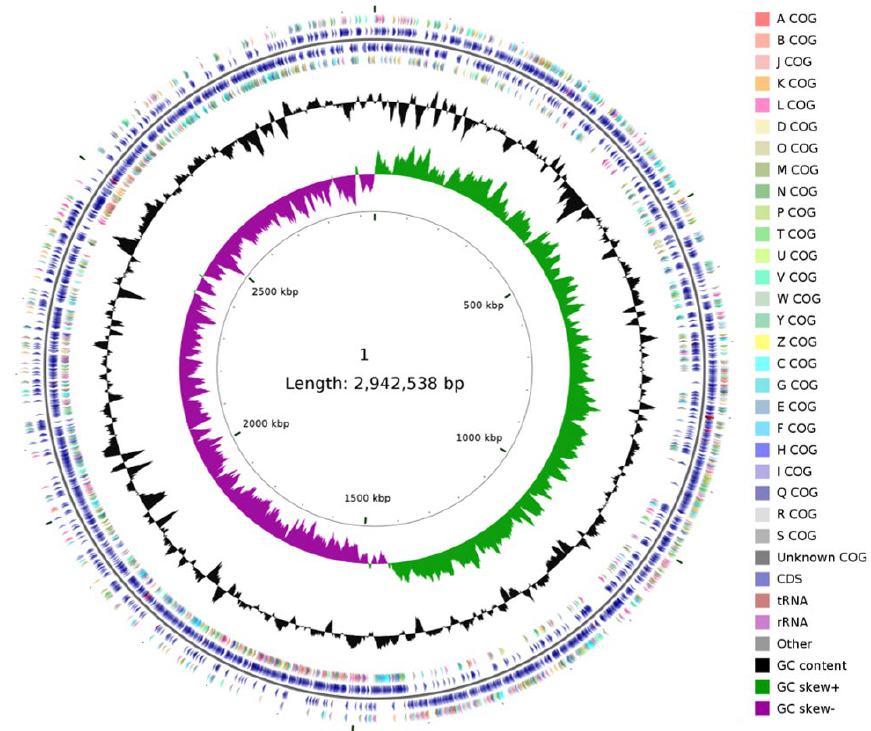
Figure 2. Circular genome map of L. paracasei TK1501. Table 2. Features of the L. paracasei TK1501 genome.